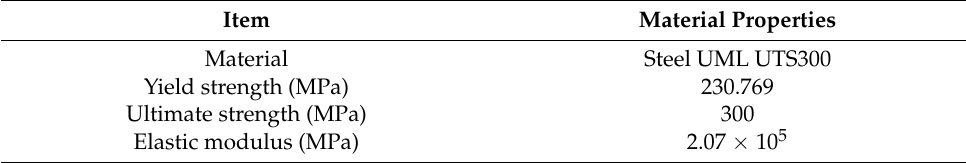
Table 3. Material properties of fastening device.